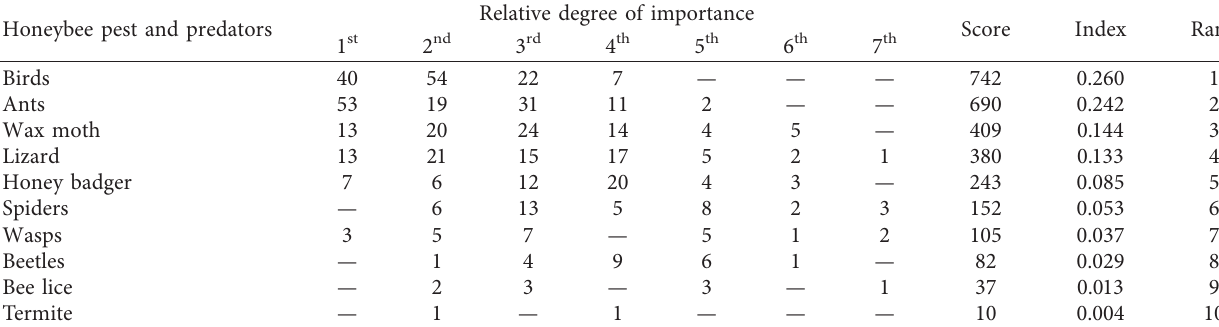
Table 11: Honeybee pests and predators of in the study areas.